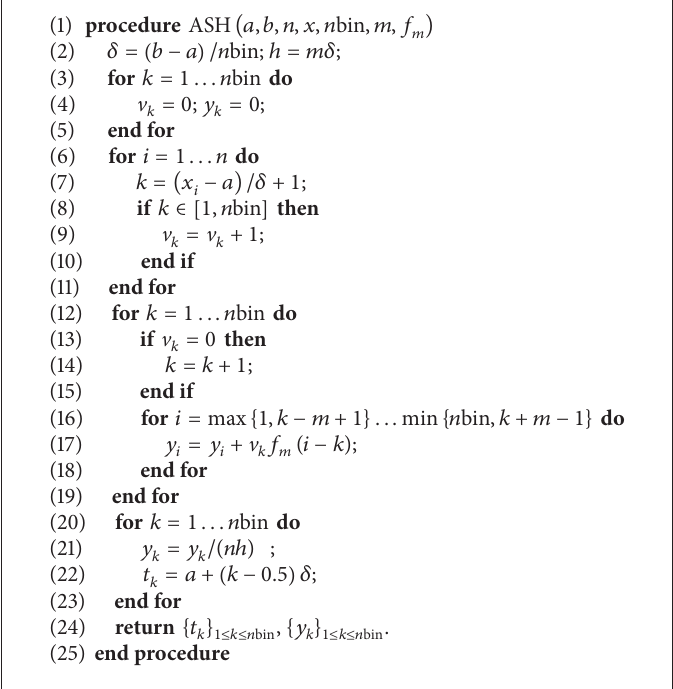
Algorithm 4: Advanced shifted histogram (1D